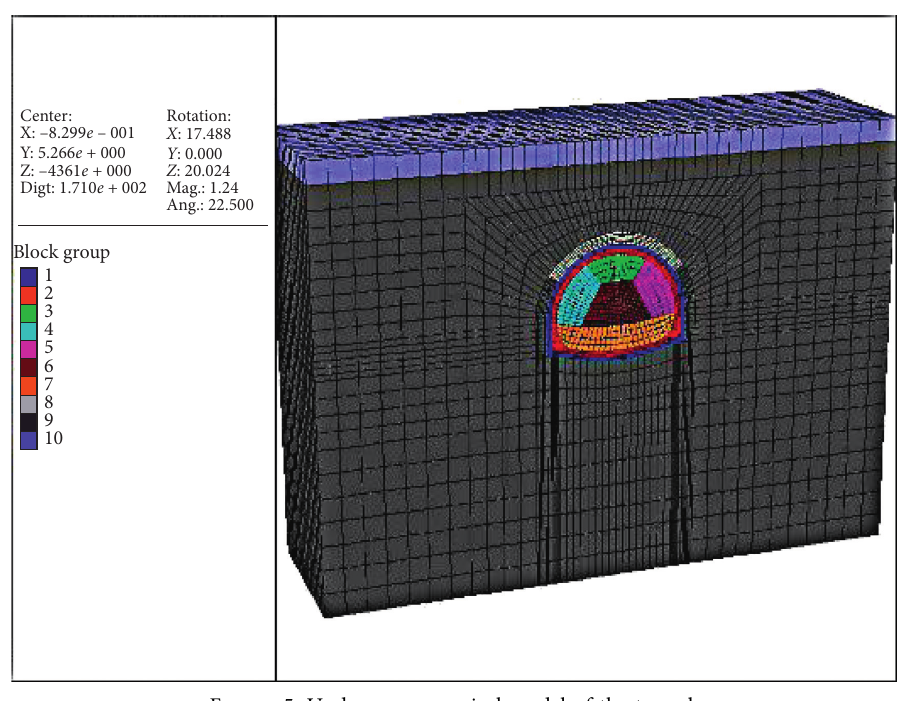
Figure 5: Underpass numerical model of the tunnel.